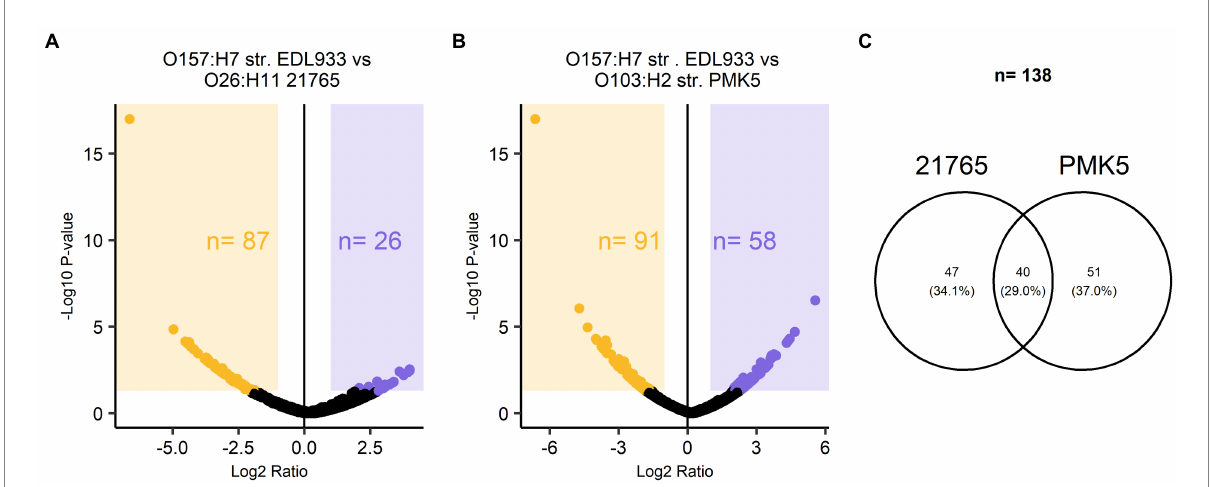
FIGURE 5 Relative quantitative description of TMT-labelled surface protein extracts of STEC O26:H11 str. 21765, O157:H7 str. EDL933, O103:H2 str. PMK5. Volcano plot of protein abundance ratios and the associated p -values for the pairwise comparisons (A) EDL933 vs. 21765 and (B) EDL933 vs. PMK5. Purple and orange panels correspond to proteins with at least a two-fold change in expression. The purple panel marks the differentially expressed proteins (DEPs) of the EDL933 strain, while the orange panel highlights those of the 21765 and PMK5 strains for (A,B) , respectively. (C) Venn diagram of proteins with at least a two-fold change in expression in the MFGMP-adhering strains, O26:H11 str. 21765 and O103:H2 str.